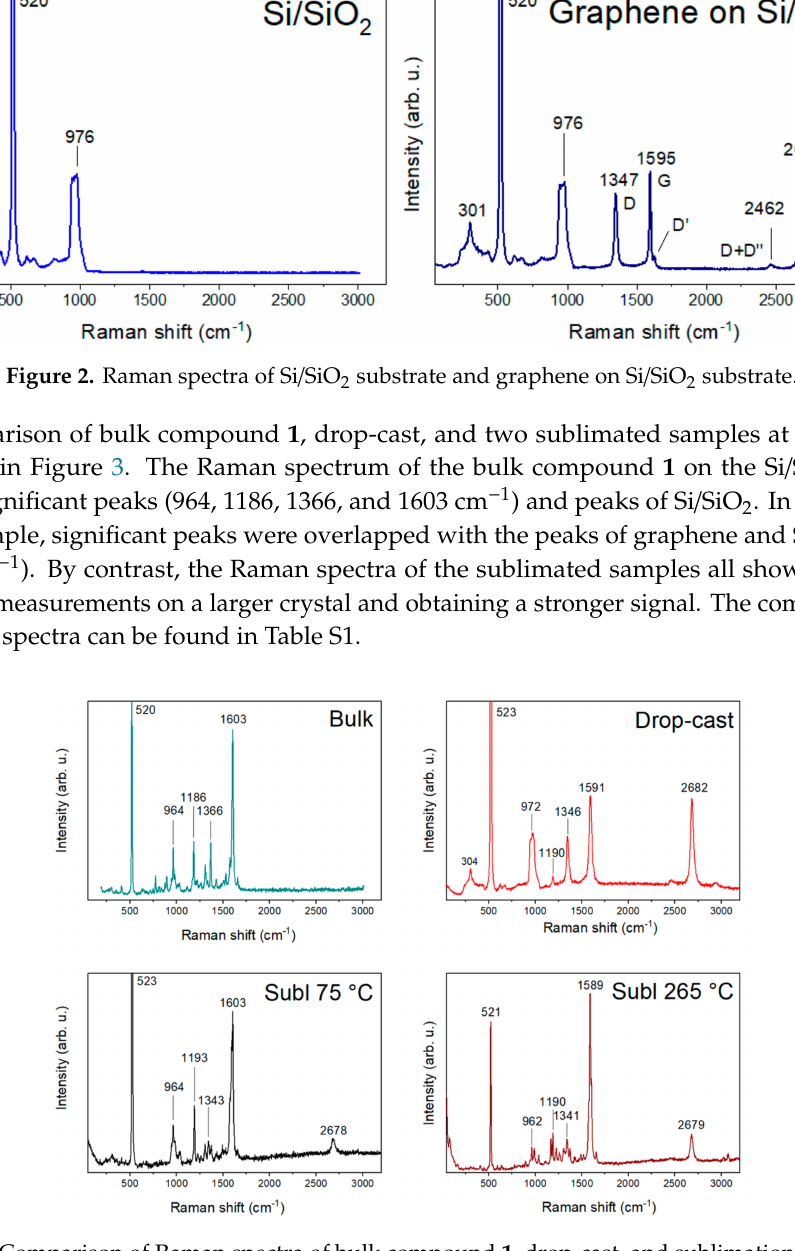
Figure 3. Comparison of Raman spectra of bulk compound 1 , drop-cast, and sublimations at 75 and 265 ◦